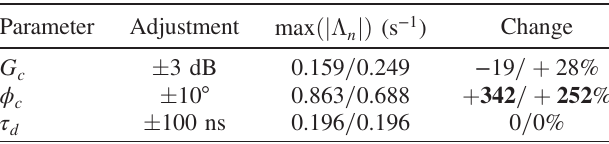
TABLE IV. Highest j Λ n j Sensitivity on llrf